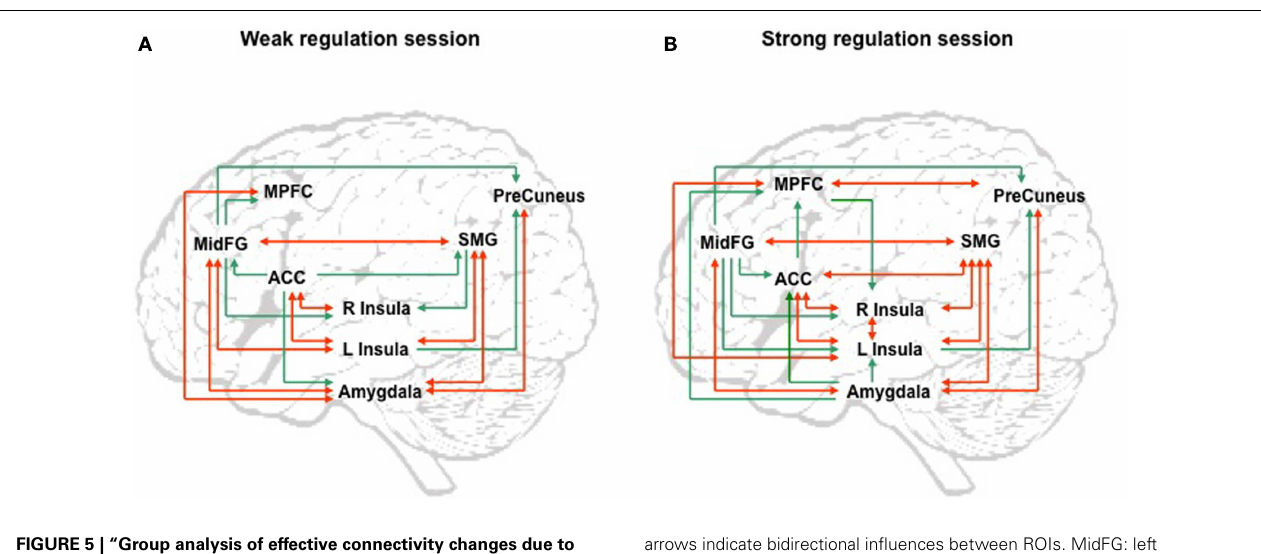
arrows indicate bidirectional influences between ROIs. MidFG: left middle frontal gyrus; MPFC: left medial prefrontal cortex; ACC: left anterior cingulate cortex; L Insula: left anterior insula; R Insula: right anterior insula; SMG: left supra marginal gyrus adapted with permission from Ruiz et al.